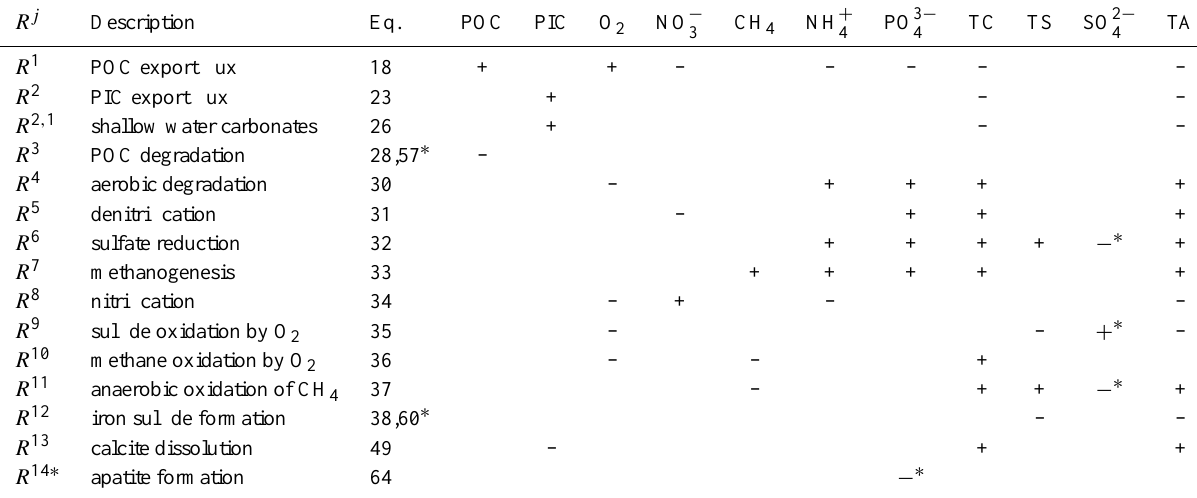
Table 5. Biogeochemical transformation processes and their influence on different elements in the ocean-sediment system. Processes that occur only in the sediment are indicated by ∗ . R